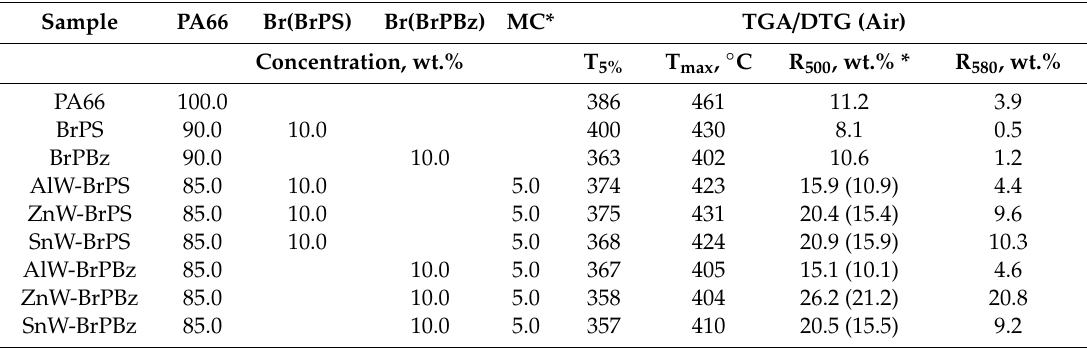
Thermogravimetric and di ff erential thermogravimetric (TGA / DTG) results for PA66 / tungstate / PolyBrFR formulations in